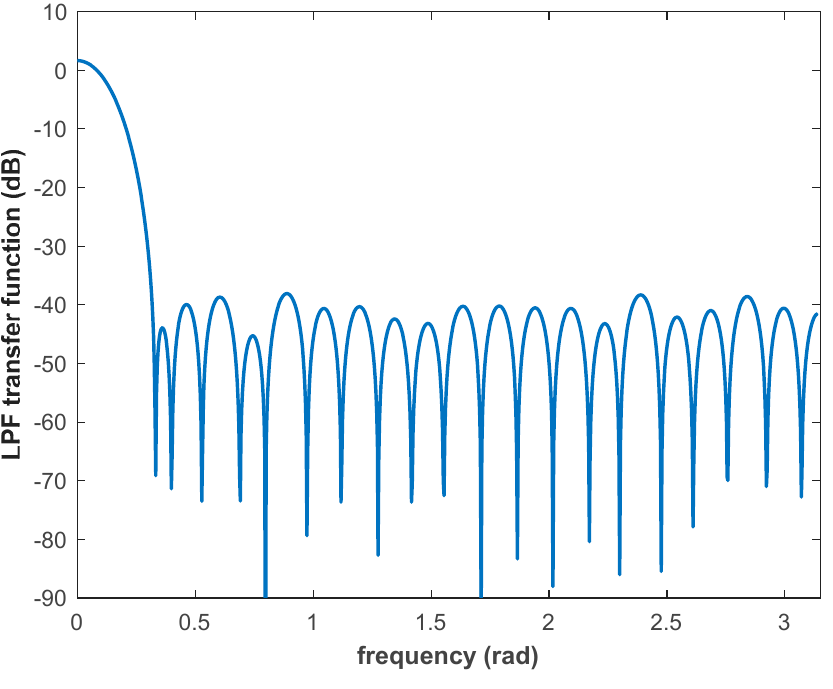
Figure 11. Demodulation LPF transfer function for the CS-SDM localization system.